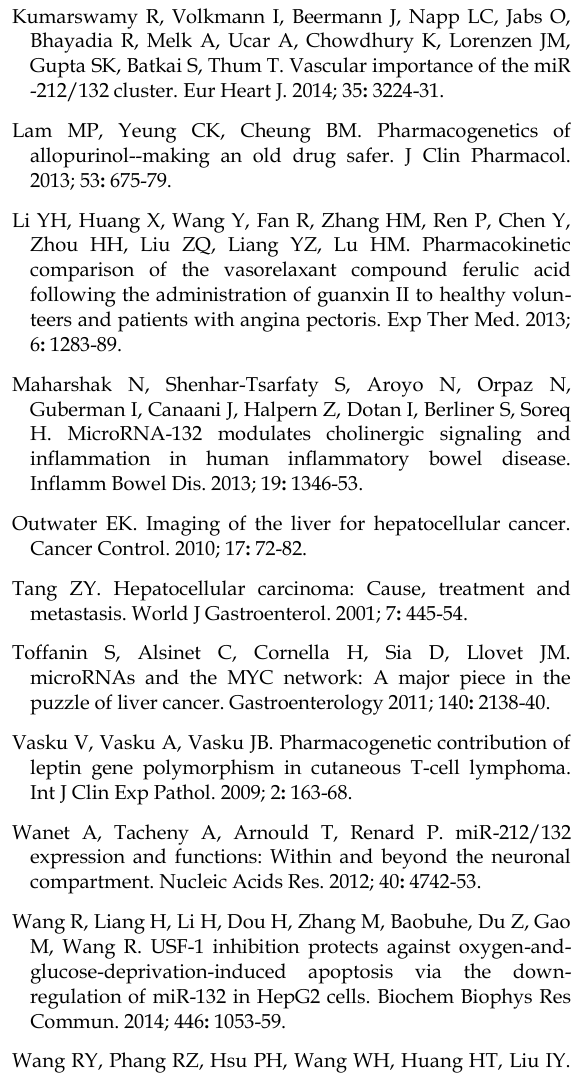
Figure 3: Mediation of microRNA-132 on apoptotic of liver cancer cell; ## p<0.01 compared with normal